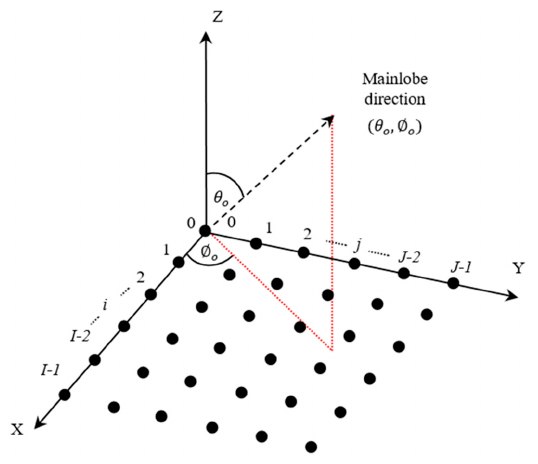
Figure 1. General uniform 2D antenna array on the XY plane with elements indexing.